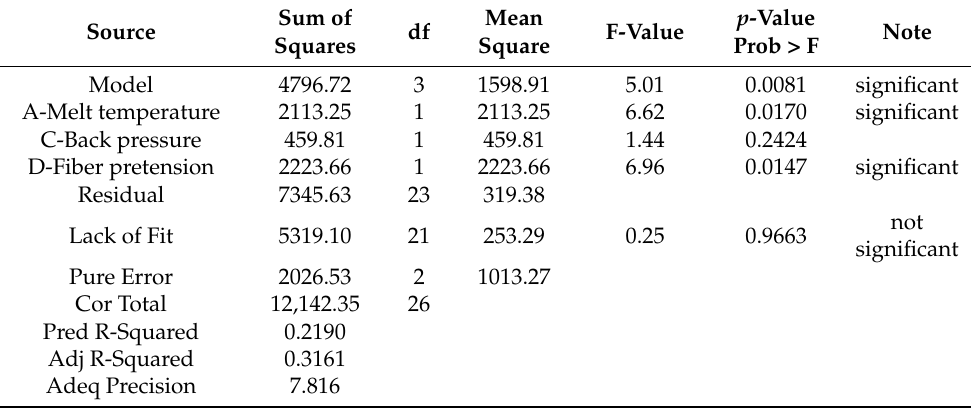
Figure 11. Influence of individual factor on the impact strength: ( A ) melt temperature; ( B ) injection pressure; ( C ) backpressure; and ( D ) fiber pretension. Table 7. ANOVA modified term for impact